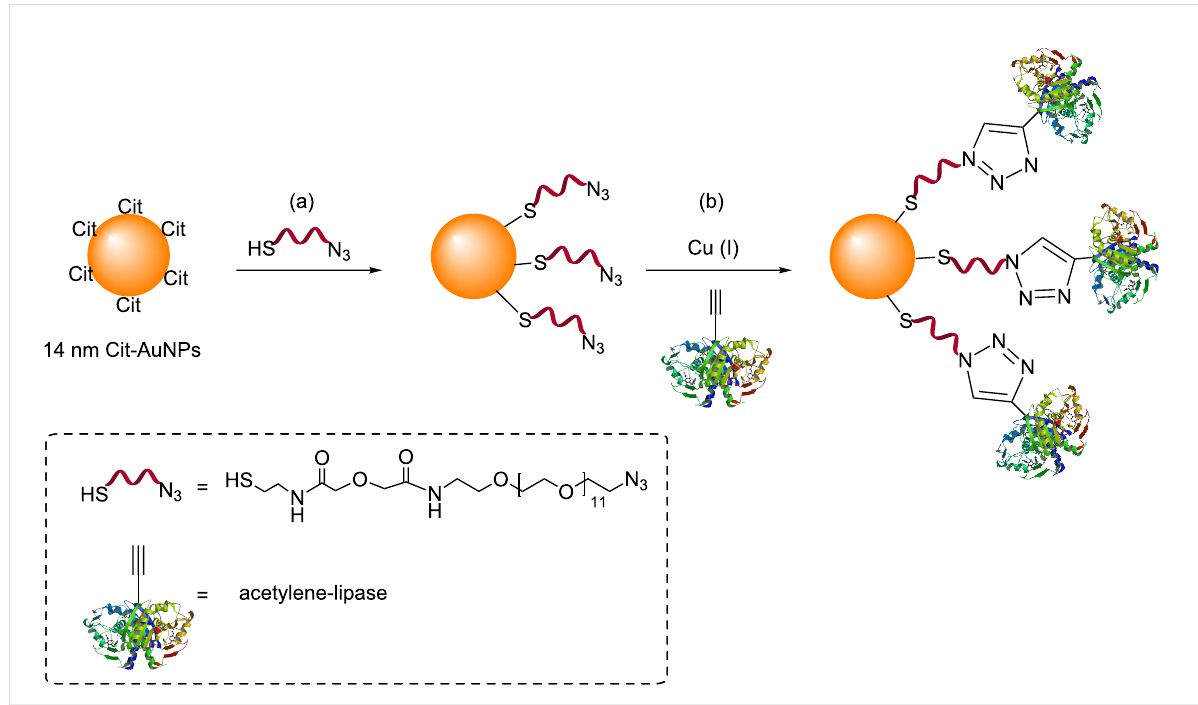
Scheme 7: Functionalization of AuNPs with an azide containing thiol ligand, and subsequent attachment to an acetylene-functionalized lipase by CuAAC. Reagents and conditions: (a) H 2 O, rt, 18 h; (b) H 2 O, CuSO 4 , ascorbic acid, rt, 3 d. [47].